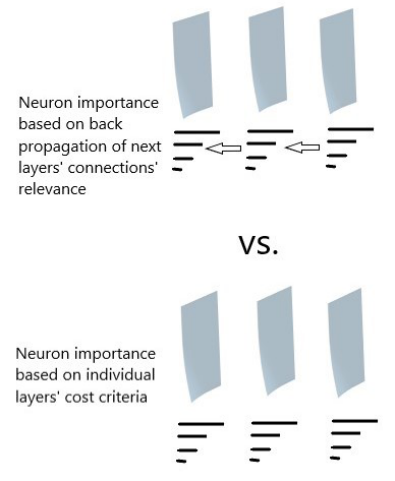
Figure 1. Comparison of the proposed